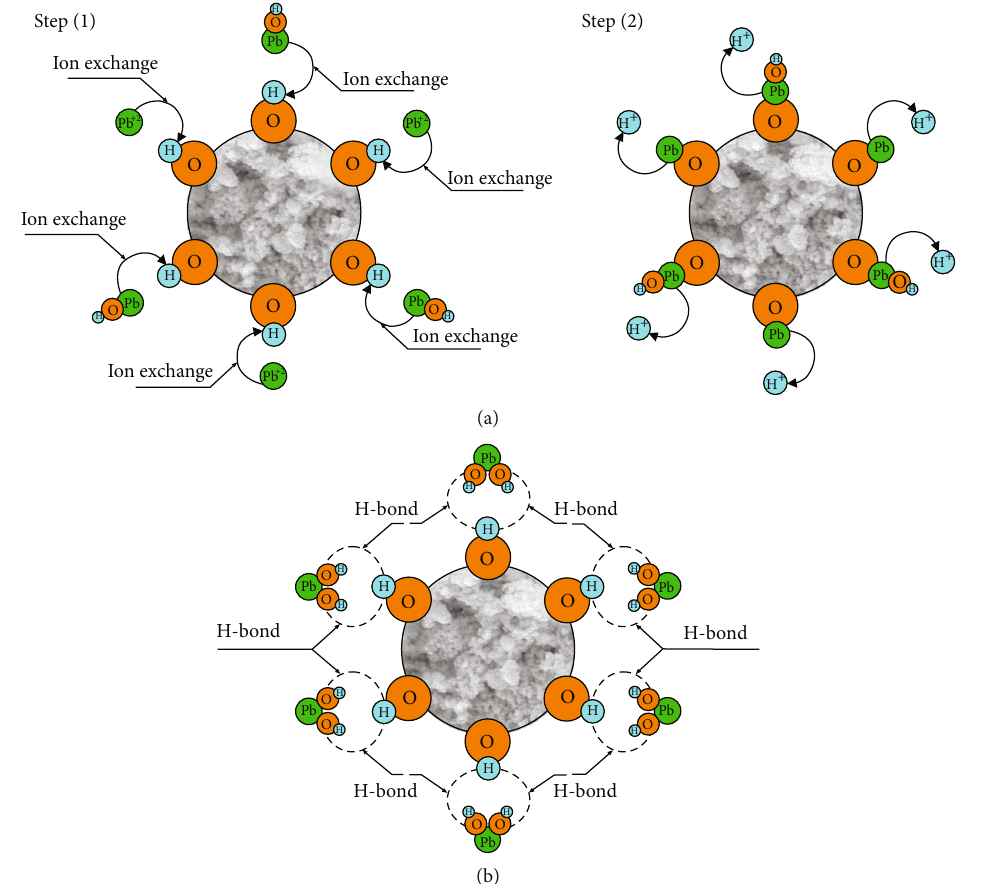
Figure 3: Adsorption mechanisms of Pb(II) on metals adsorbent surfaces: (a) ion exchange mechanism and (b) hydrogen bonding